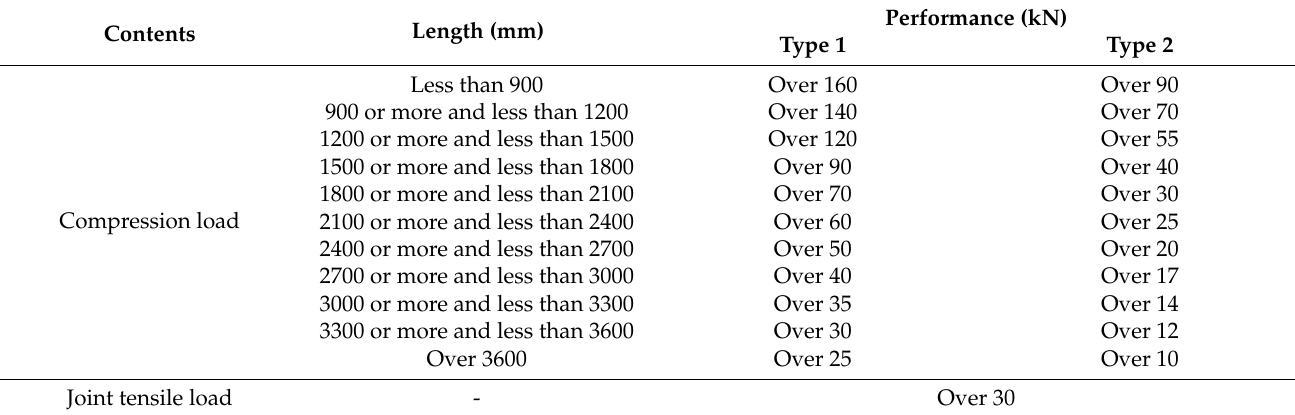
Table 1. Test performance standards for the main posts of the prefabricated shoring system in Korea [36].